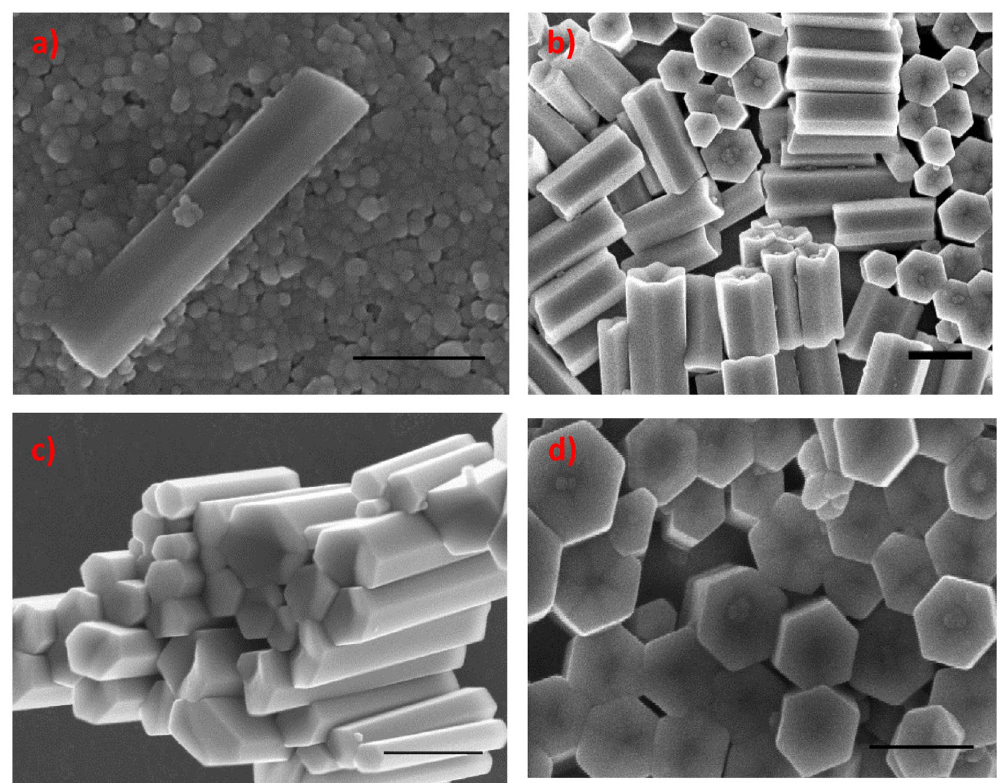
Figure 3. ( a – d ) SEM characterization of NaYF 4 :Yb 3 + , Er 3 + (20, 2 mol%) nanoparticles doped with various concentrations of Gd 3 + ions. ( a ) shows the SEM image of the NaYF 4 :Yb 3 + , Er 3 + (20, 2 mol%) UC nanoparticles. ( b ) shows the SEM image of the NaYF 4 :Yb 3 + , Er 3 + (20, 2 mol%) @Gd 3 + doping (30 mol%) UC nanoparticles. ( c ) shows the SEM image of the NaYF 4 :Yb 3 + , Er 3 + (20, 2 mol%) @Gd 3 + doping (50 mol%). ( d ) shows the SEM image of the NaYF 4 :Yb 3 + , Er 3 + (20, 2 mol%) @Gd 3 + doping (70 mol%) UC nanoparticles. The scale bars in figure ( a – d ) are 500